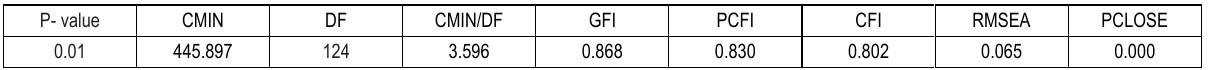
Table 3. Confirmatory Factor Analysis results